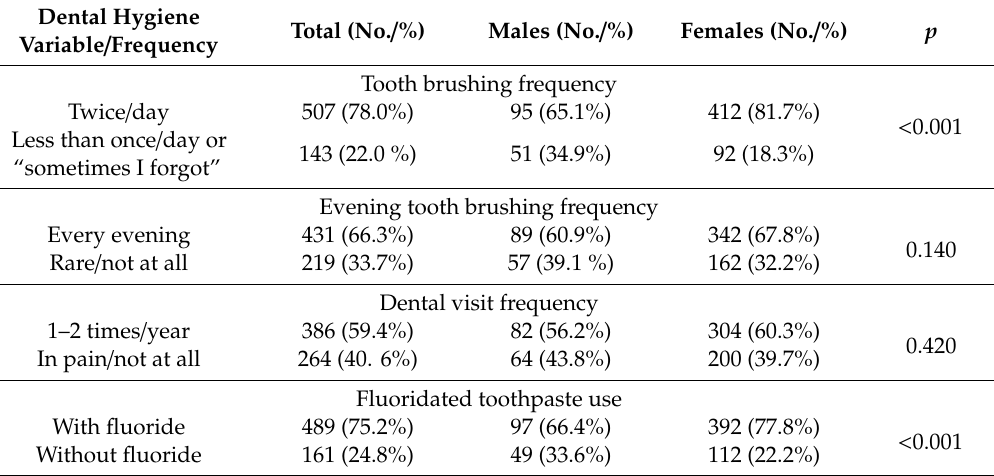
Table 1. Oral hygiene behaviors of the studied